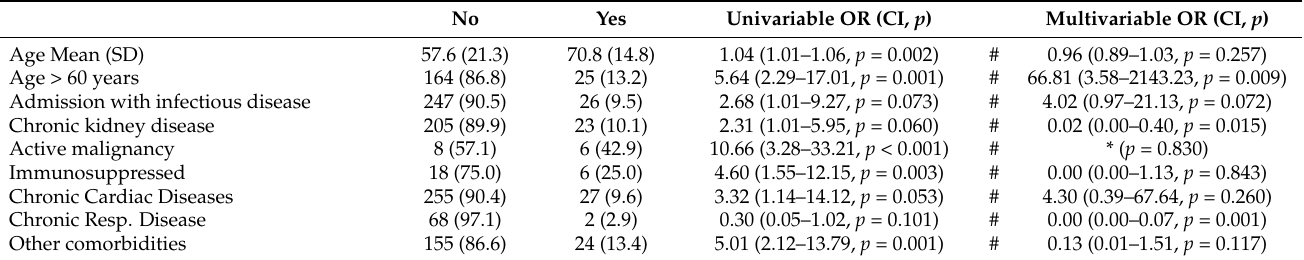
Table 4. Predictors for infection-related 28-day mortality